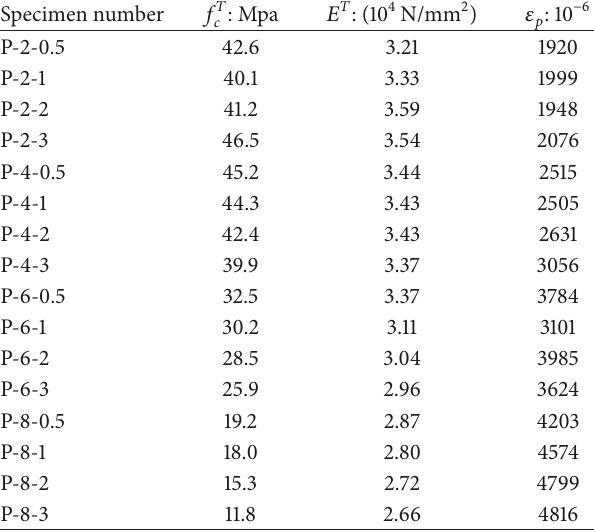
Table3:BasicmechanicalvaluesofHSCafterdifferenthightemper- ature processes.